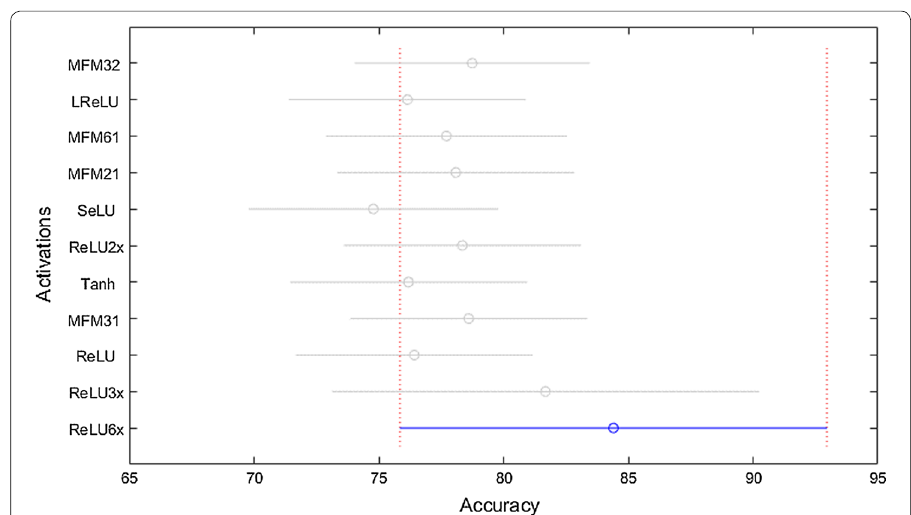
Fig. 16 Multiple comparisons, activations on all datasets